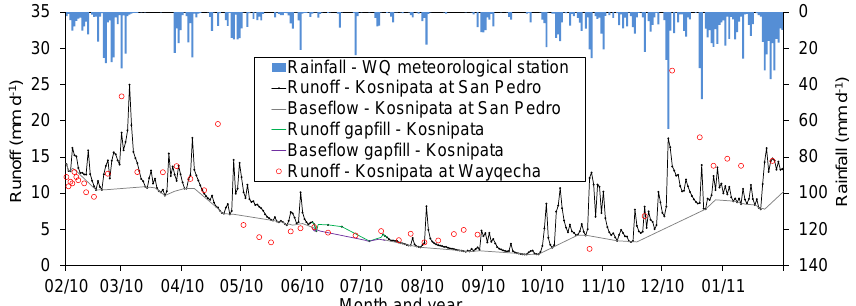
Figure 3. Run-off for the Kosñipata River at the San Pedro and Wayqecha gauging stations. Rainfall (top axis) from the Wayqecha (WQ) meteorological station is on the secondary axis. The Kosñipata River run-off at San Pedro and baseflow were measured nearly continuously through the year, with a 31-day gap partly in July and August that is covered by three manual measurements. The gap was filled using linear interpolation. The Kosñipata River run-off at Wayqecha was measured throughout the year from a daily to a monthly interval and is discussed in the